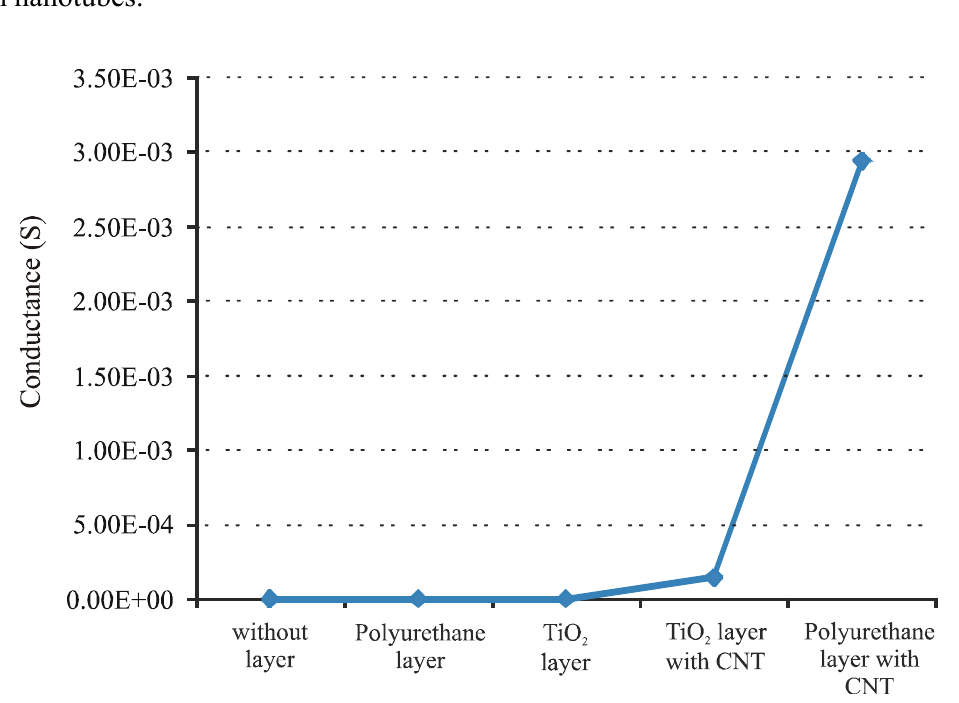
Figure 8. Conductance of titania and polyurethane layers with and without multi-walled carbon